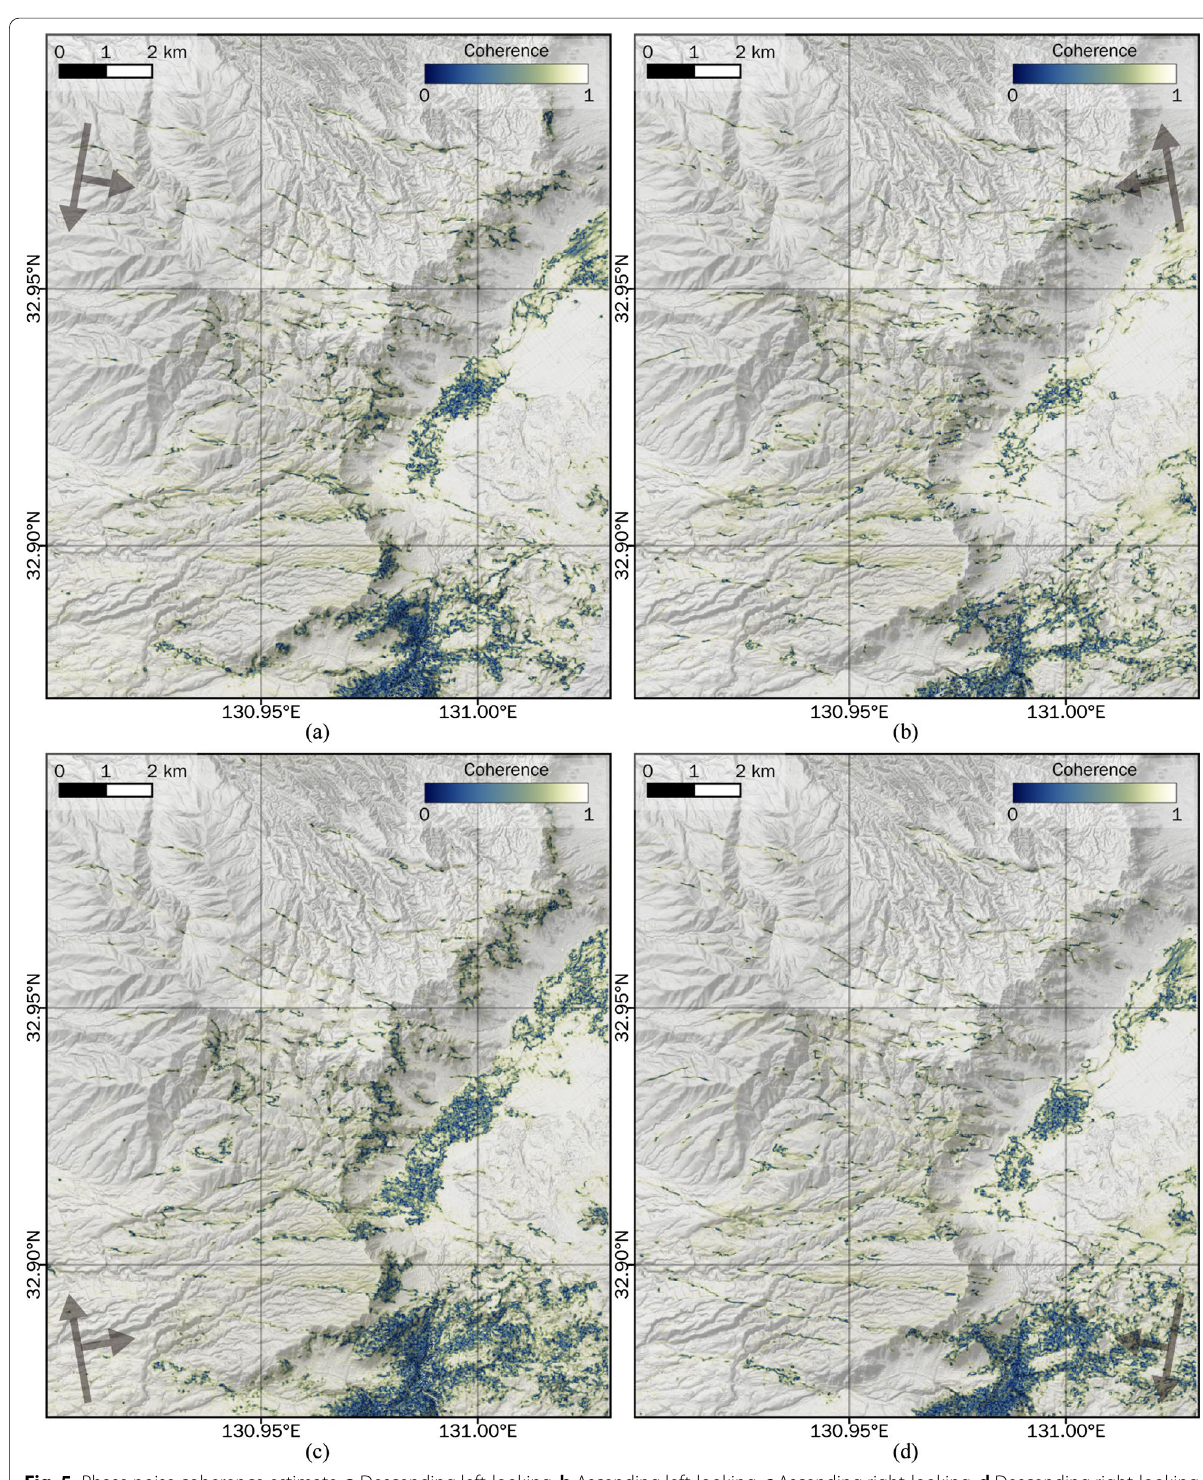
Fig. 5 Phase noise coherence estimate. a Descending left-looking. b Ascending left-looking. c Ascending right-looking. d Descending